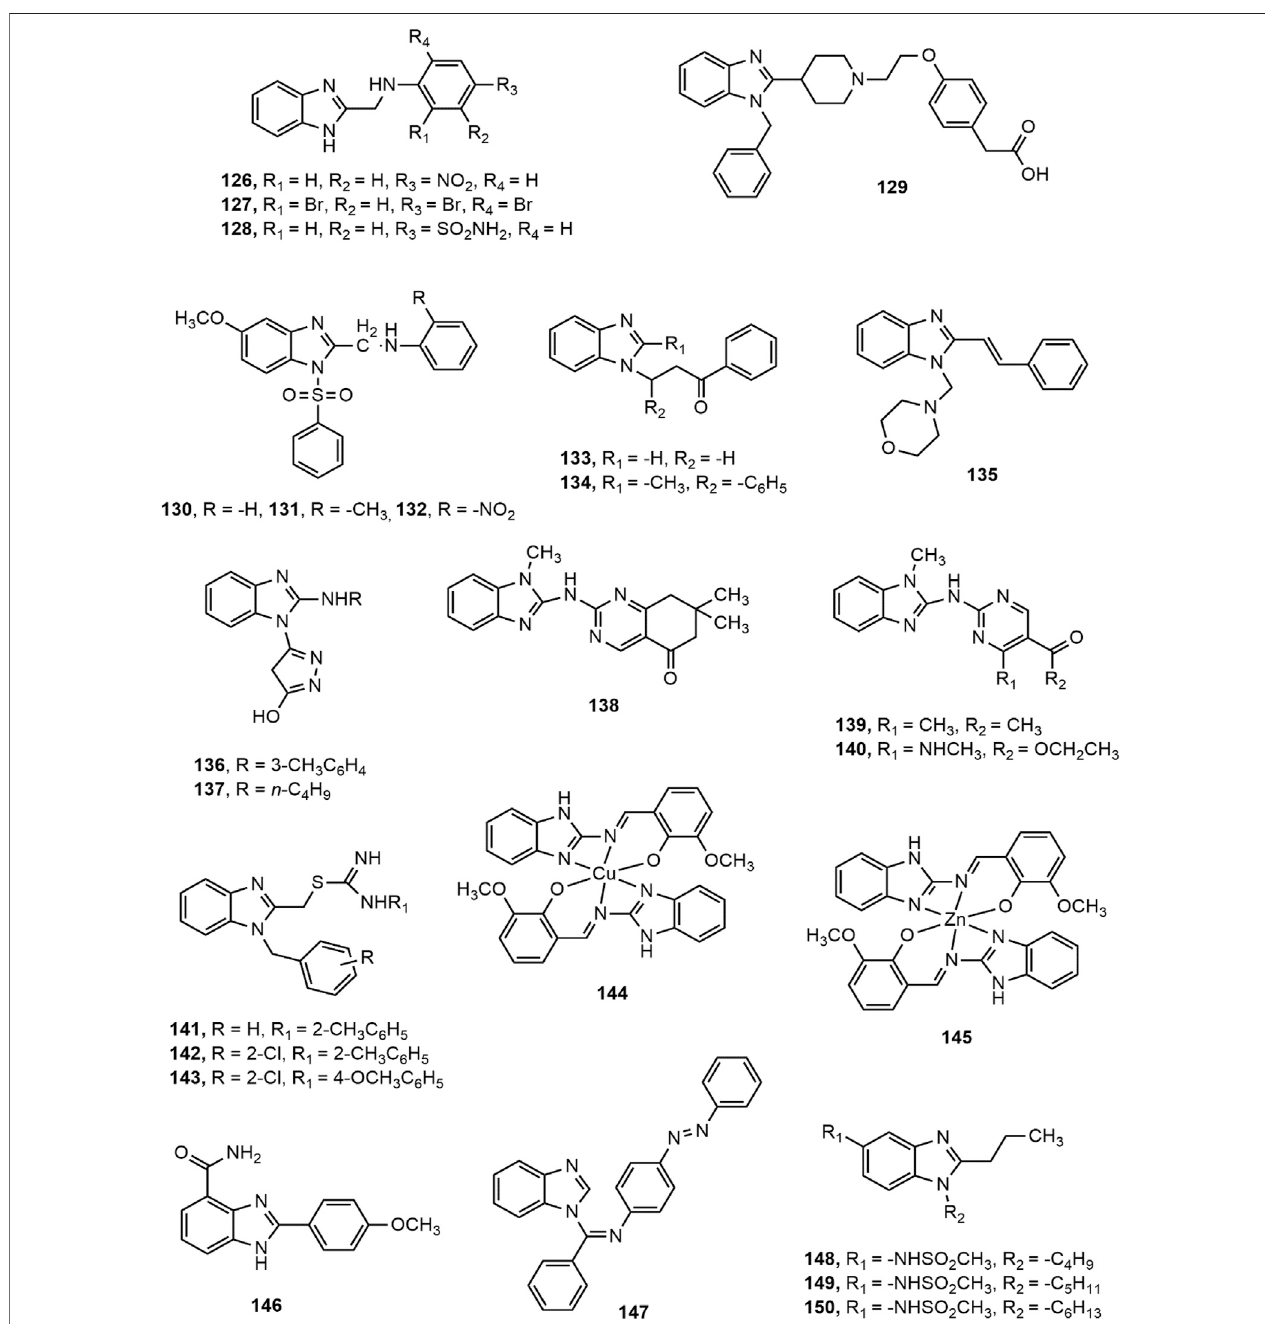
FIGURE 5 | Benzimidazole derivatives with anti-in fl ammatory and analgesic activity.